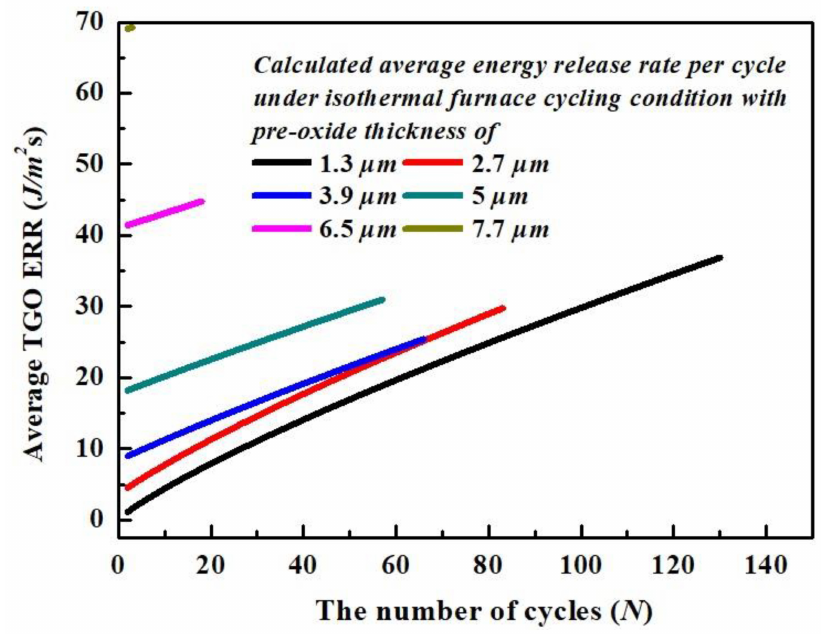
Figure 12. The calculated average TGO ERR vs. the number of cycles with respect to different pre-oxide thicknesses for isothermal furnace cycling